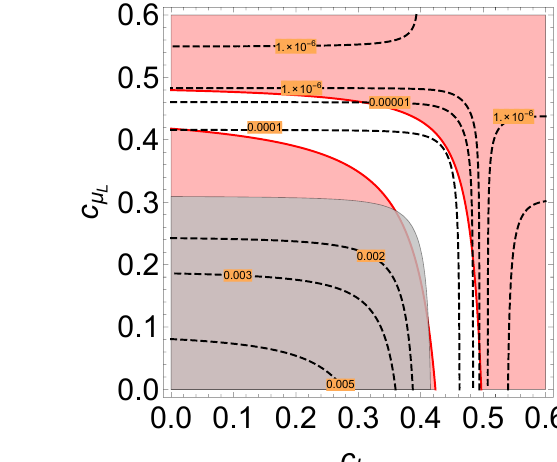
[ Z n (cid:22) + (cid:22) (cid:0) ] for n = 1 (cid:1) B !